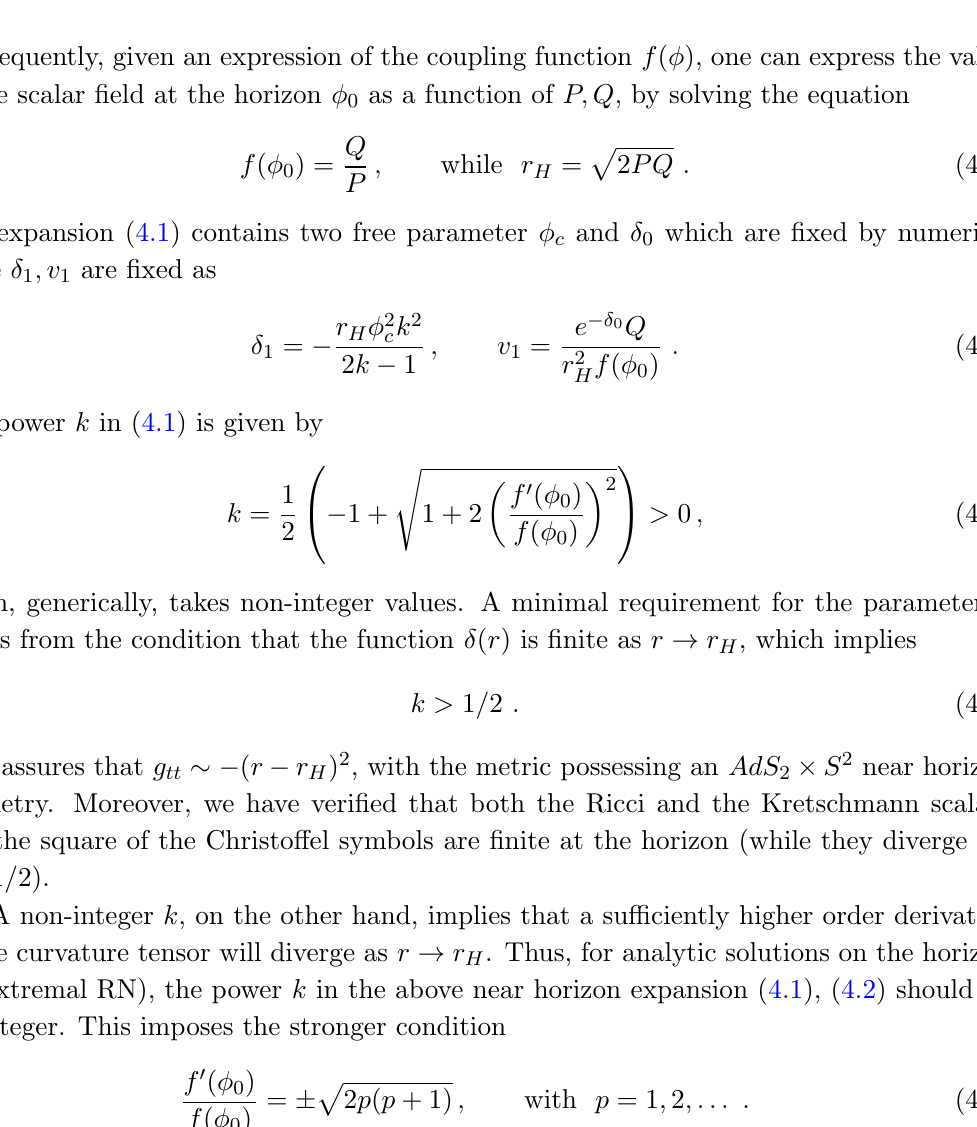
Figure 5 . Domain of existence of dilatonic BHs (left panel) and scalarised BHs (right panel) for several values of the ratio P=Q